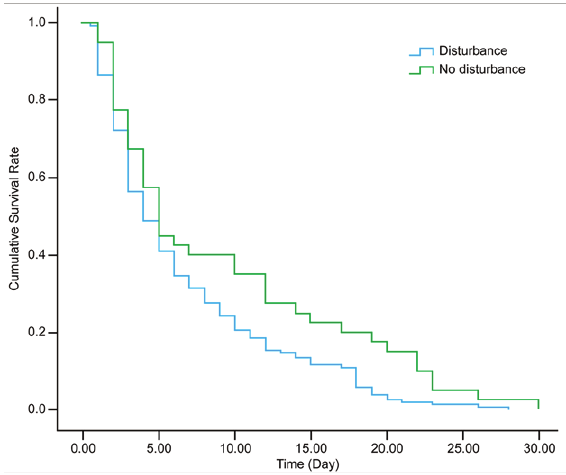
Figure 2: The impact of glucose level on the survival rate of young adult patients with intracranial hemorrhage. Patients with cerebral hemorrhage who showed elevated blood glucose levels tended to have shorter survival times and a higher risk of